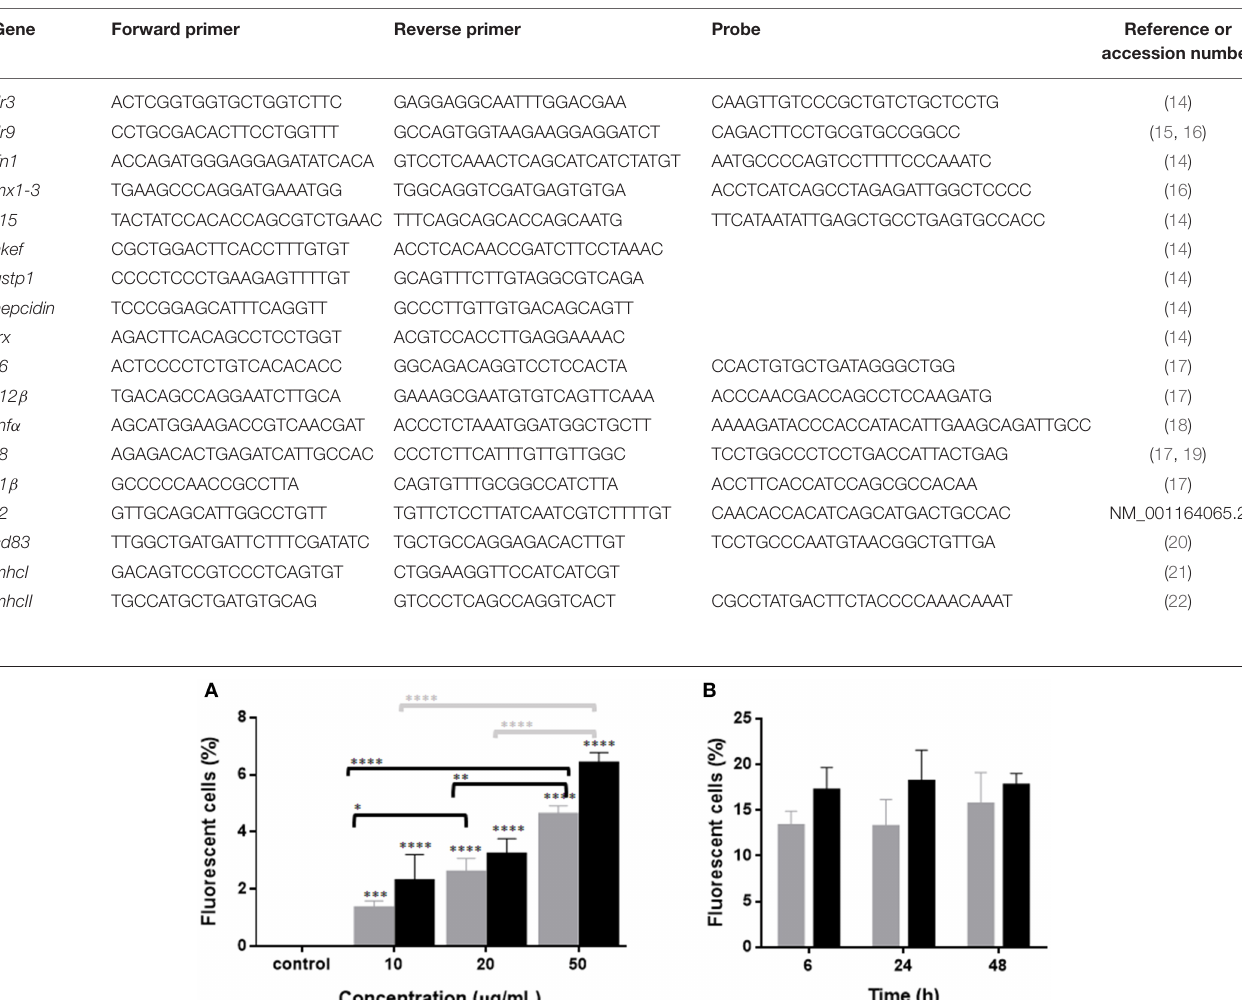
TABLE 1 | List of primers and probes used.